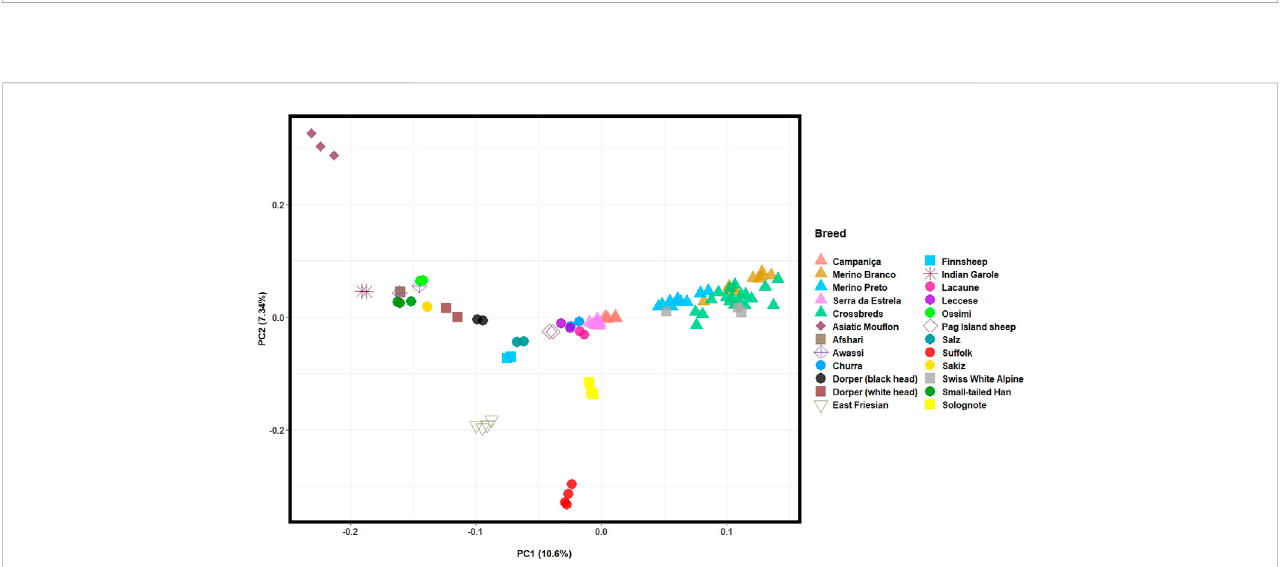
FIGURE 5 Principal component analysis (PCA) of Iberian and worldwide sheep. PC1 and PC2 account for 10.3% and 7.27% of the total genomic variation, respectively. The Portuguesesheep arerepresented bycolouredtriangles,as follows: Campaniça insalmon; MerinoBrancoingoldenbrown;MerinoPretoin blue; Serra da Estrela in pink; and Crossbreds in green. See Supplementary Table S2 for details on each individual included in the